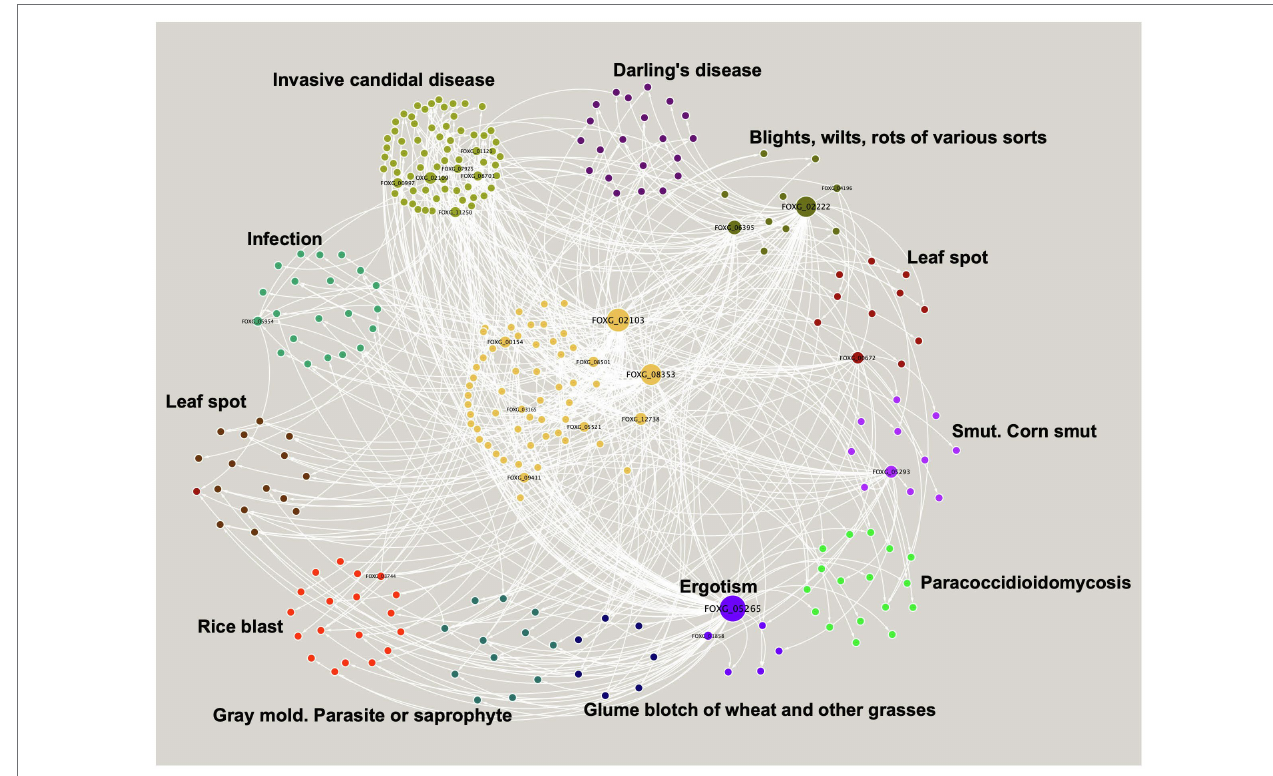
FIGURE 3 | Virulence module in F. oxysporum . Nodes represent TFs and TGs, and the white edges represent regulatory interactions. The clusters show the most abundant diseases represented in the virulence module. The size of a node is proportional to its degree of